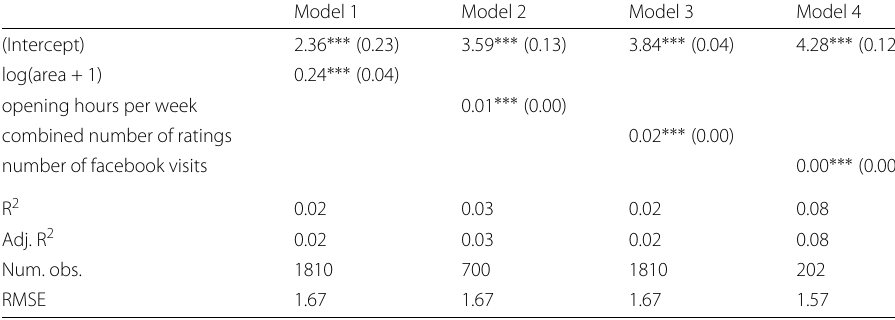
Table 3 Linear regression models explaining logaritmized CPD with each influencing factor separately Model 1 Model 2 Model 3 Model 4 (Intercept) 2.36 ∗∗∗ (0.23)